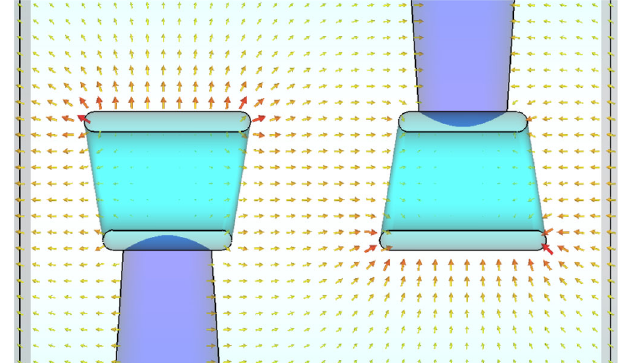
FIG. 10. Electric-field lines in the axial vertical plane of one IH period with wide gaps and DTs with slanted ends. The field logarithmic scaling is the same in Figs. 8 and 10.